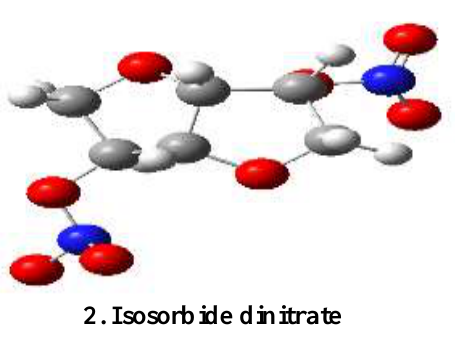
Figure 11: Equilibrium geometry of the inhibitors molecules calculated by DFT (B3LYP/6-311G (d,p))